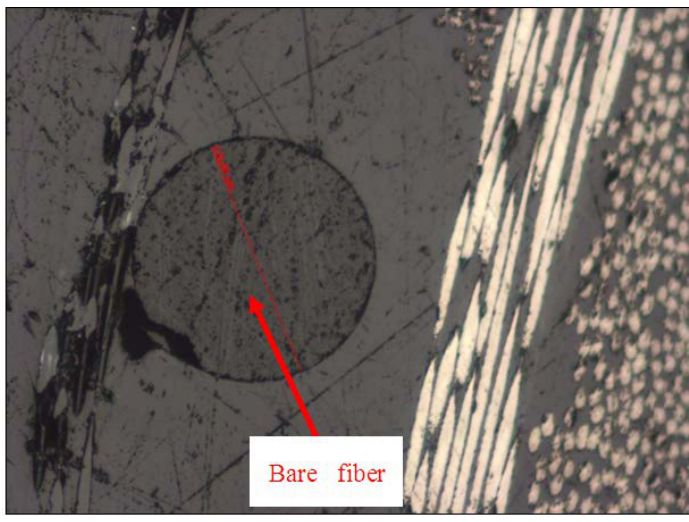
Figure 5. Embedded bare fiber without coating. The fiber has an excellent adhesion to the